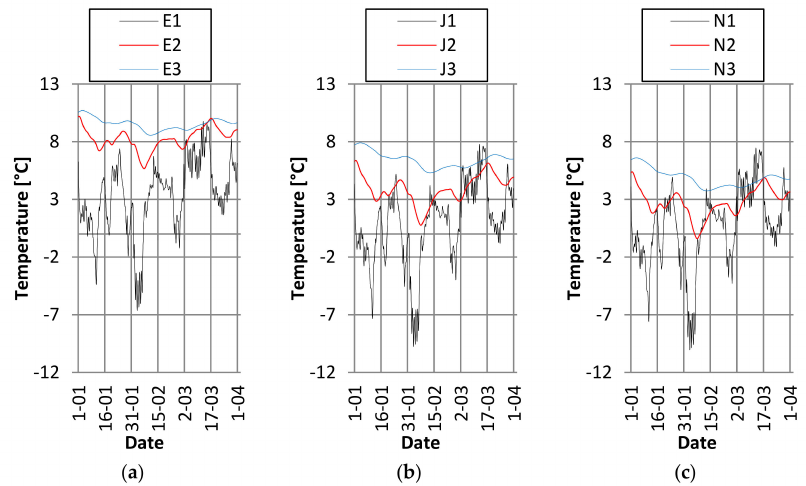
Figure 5. Soil temperature in lines E, J, and N on selected days during the winter season.